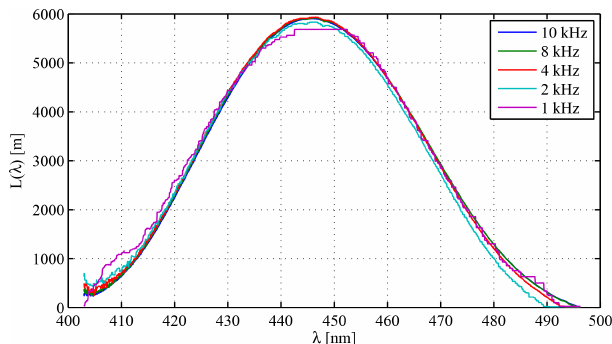
Figure 14. Successful ICOM path length retrieval using artificially reduced modulation frequencies ν